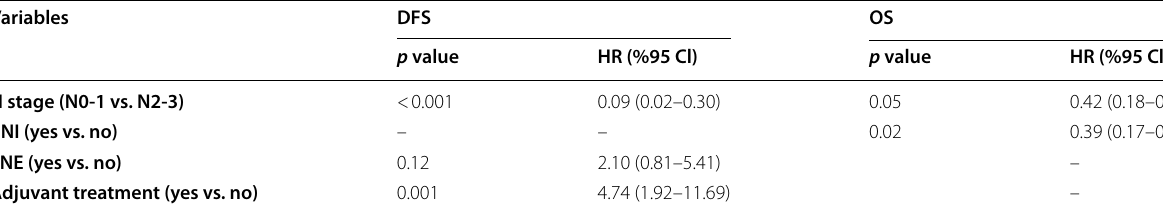
Table 4 Multivariate analysis of different variables affecting DFS and